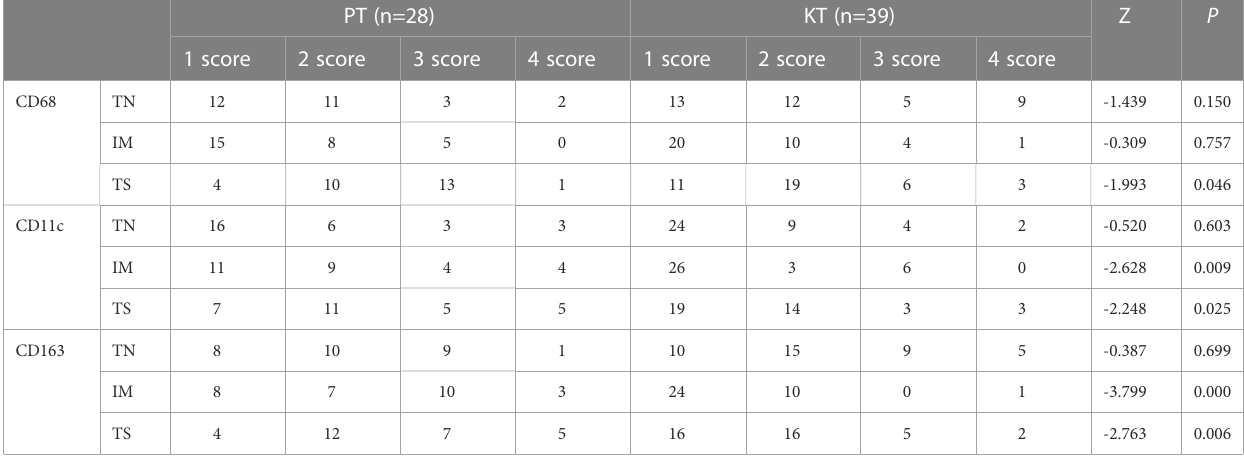
TABLE 2 Comparison of TAMs in fi ltration abundance between primary tumors and KT tissues.